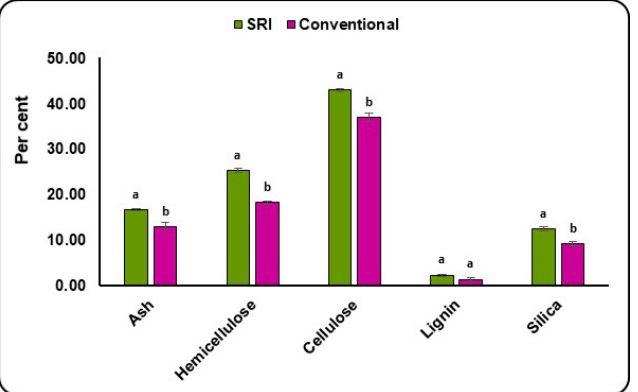
Figure 9. Biochemical parameters with different methods of rice cultivation. Means with the same letter are not significantly different by Tukey’s HSD ( p = 0.05) for each parameter.